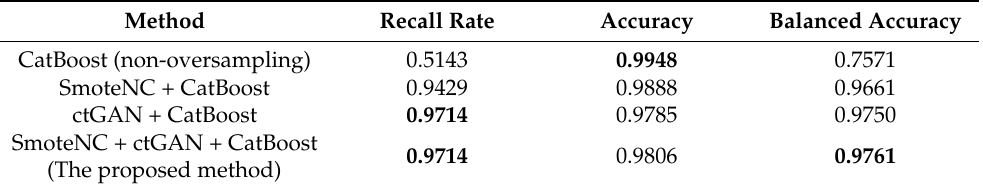
Table 10. Prediction results obtained for the HDF diagnosis using other methods used for processing limited data.